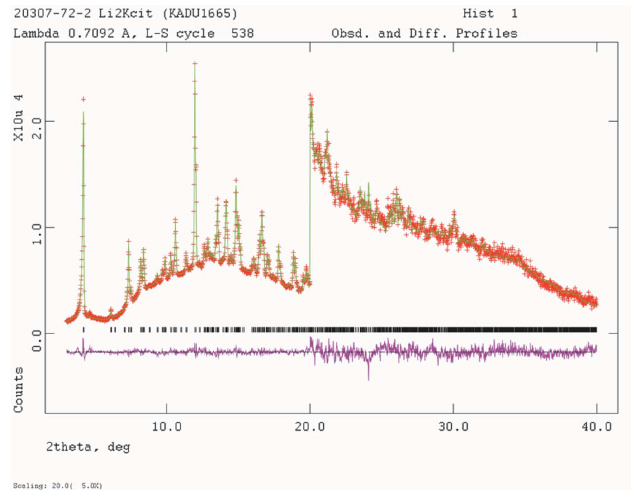
Figure 6 Rietveld plot for Li 2 KC 6 H 5 O 7 . The red crosses represent the observed data points, and the green line is the calculated pattern. The magenta curve is the difference pattern, plotted at the same scale as the other patterns. The vertical scale has been multiplied by a factor of five for 2 (cid:3) > 20.0 (cid:2) . The row of black tick marks indicates the reflection positions for this phase.